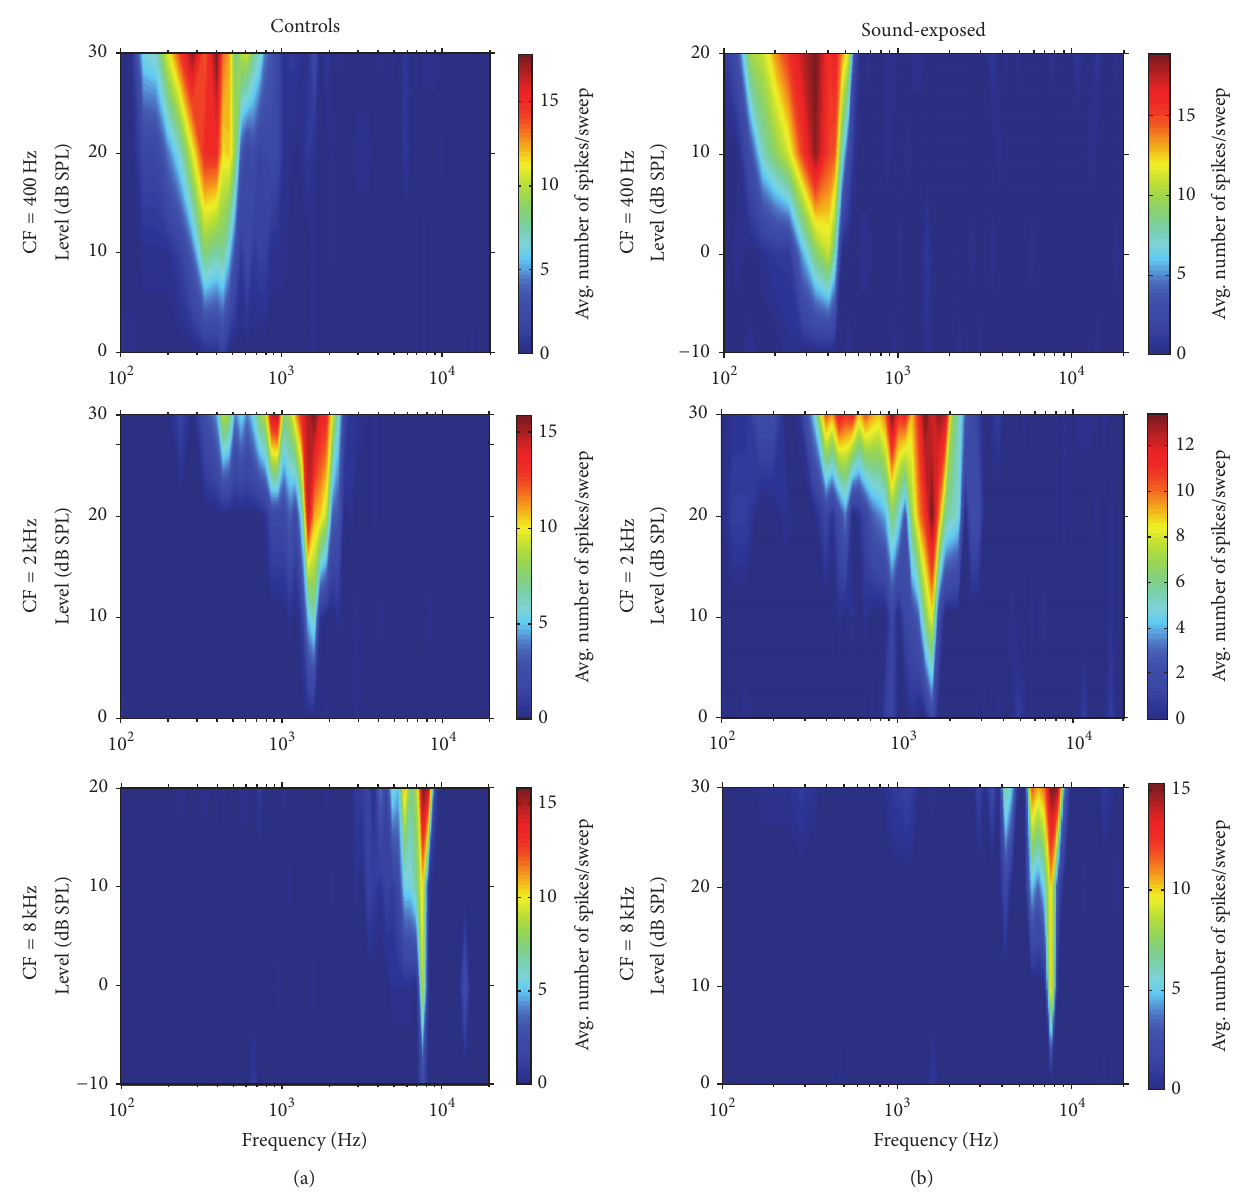
Figure 6: Representative frequency tuning curves in IC for low, mid, and high characteristic frequency (CF) neurons in control (a) and sound-exposed animals